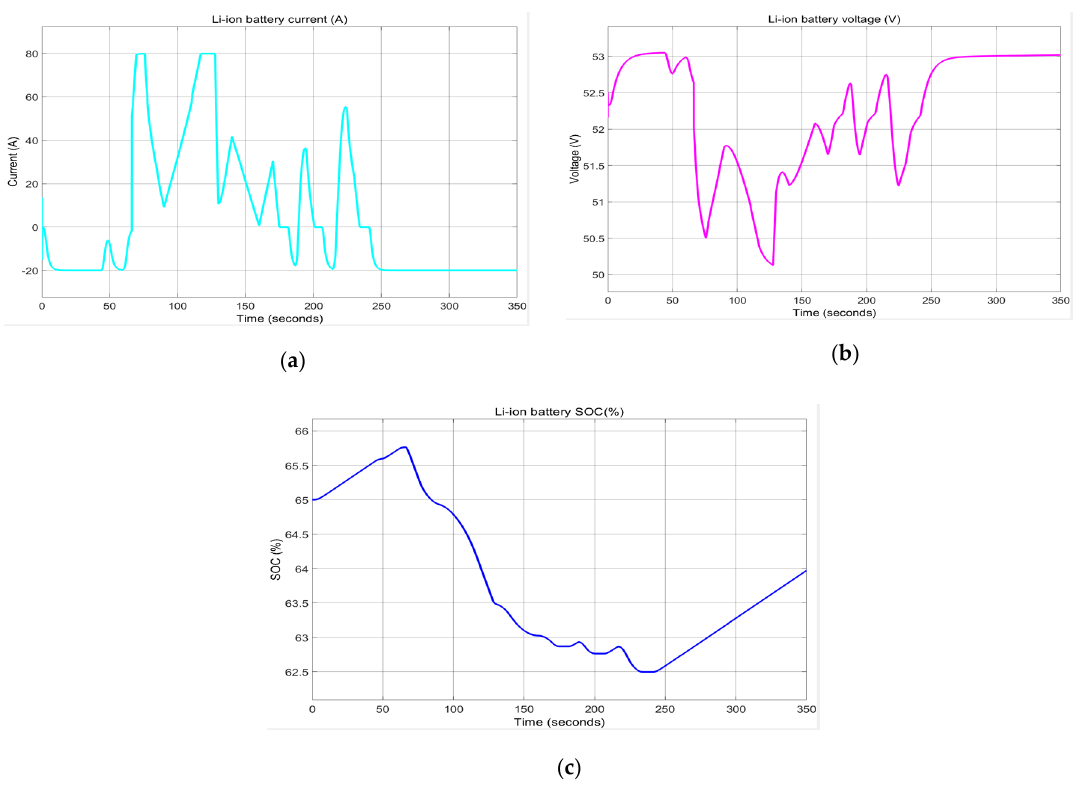
Figure A9. Li-ion battery specific variables. ( a ) Battery current; ( b ) battery voltage; ( c ) battery SOC.